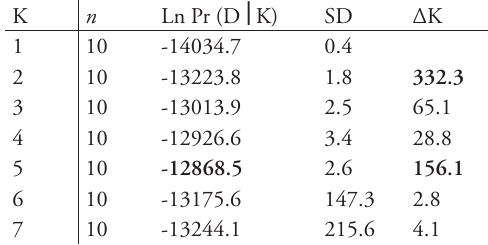
Table 1 Mean posterior probability (Ln Pr (D  K)), standard deviation (SD) and delta K across n runs with STRUCTURE given different numbers of subpopulations (K ∈ [1,7]) for 419 Norwegian red deer genotyped in 14 microsatel- lite loci (from Haanes et al ., 2010). The most likely number of clusters according to Baye’s theorem (K=5; P >0.99) and delta K, are marked in